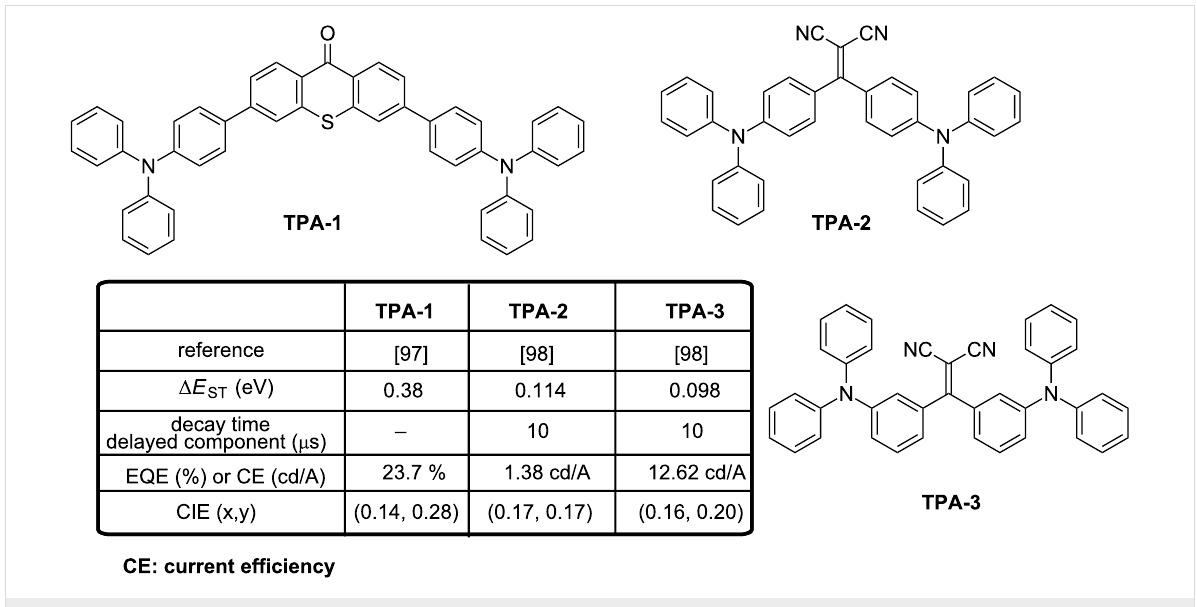
Figure 20: Triarylamine-based emitters TPA-1 – TPA-3 .